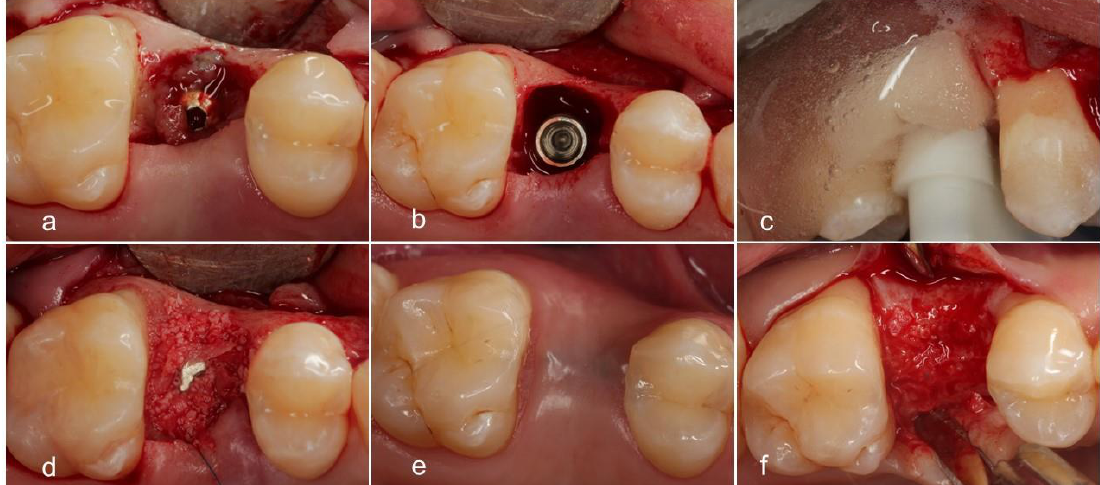
Table 4. Bone gain in relation to RP class. 244